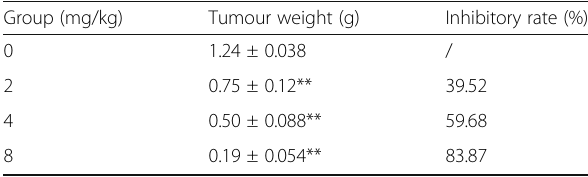
Table 5 Comparison anti-tumor effects on experimental groups Group (mg/kg) Tumour weight